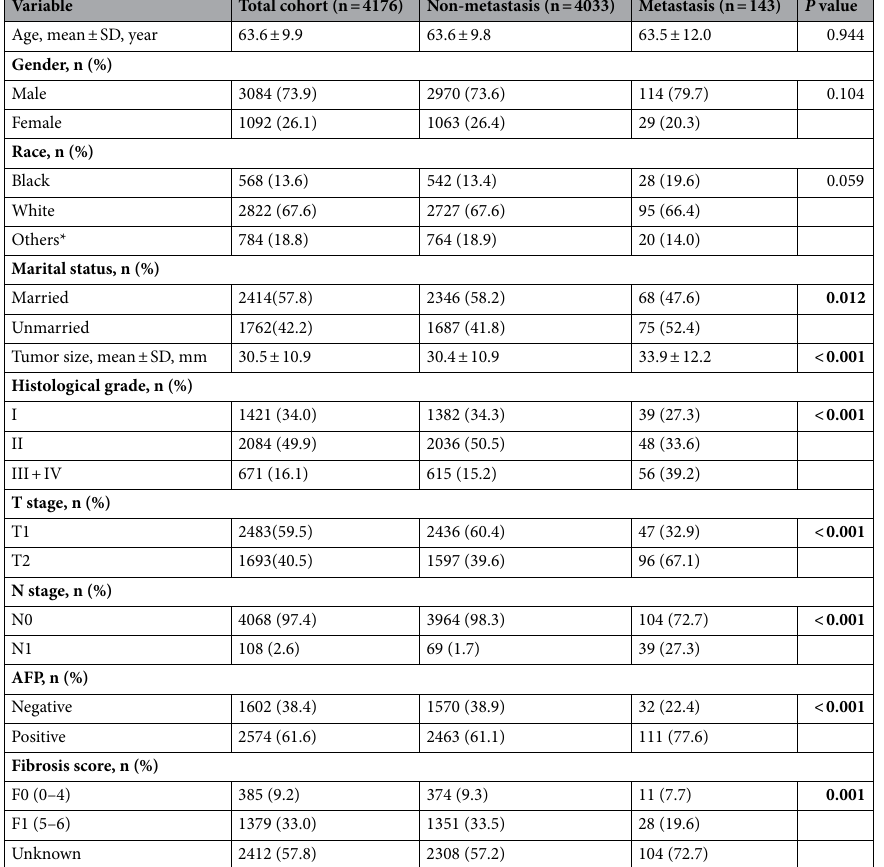
Table 1. Clinicopathological characteristics of patients with small HCC and their differences between distant metastasis and non-distant metastasis groups. Significant values are in bold. *The others comprise